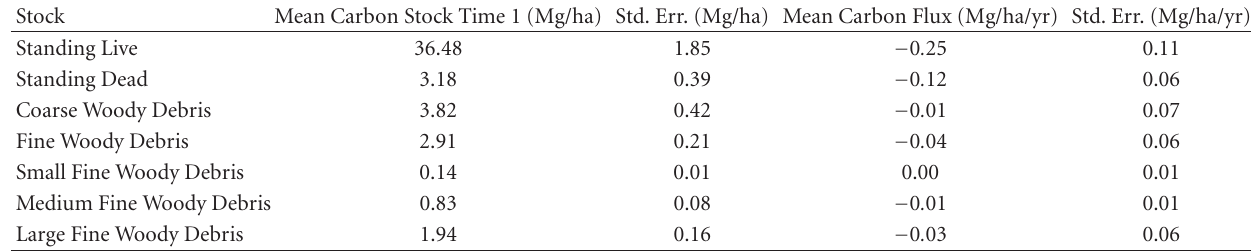
Table 1: Mean stock density (time 1, 2002) and average annual carbon flux for standing live/dead trees and down woody materials (fine and coarse) where a negative estimate indicates a net sequestration north central across the United States, 2002 to 2007 (obs = 182).